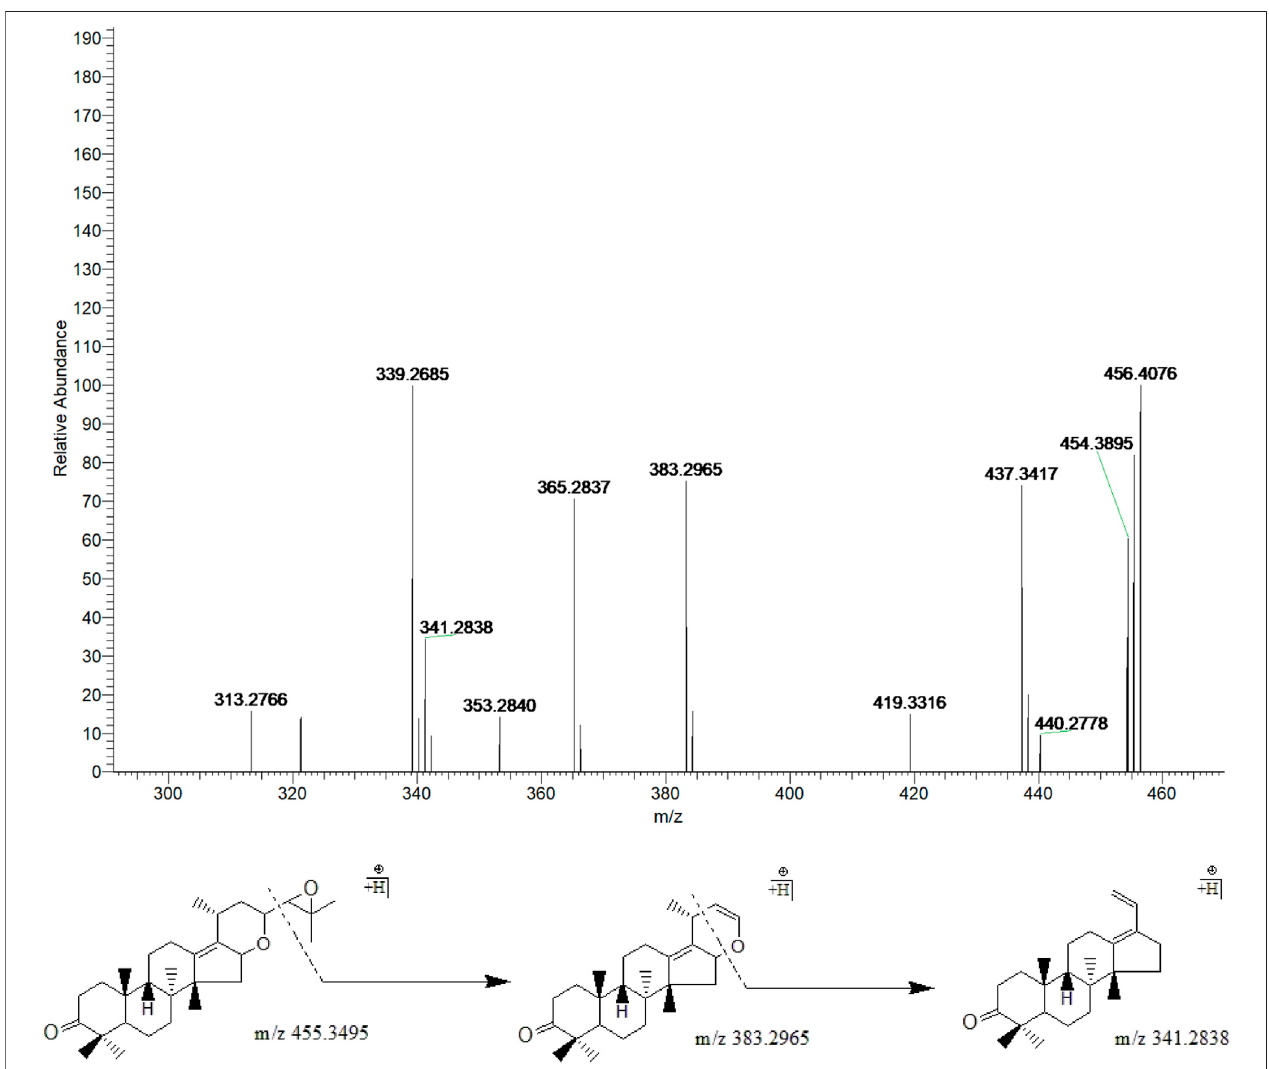
FIGURE 7 | The second-order mass spectrometry graphs and proposed fragmentation pathways of alisol I (peak 23).